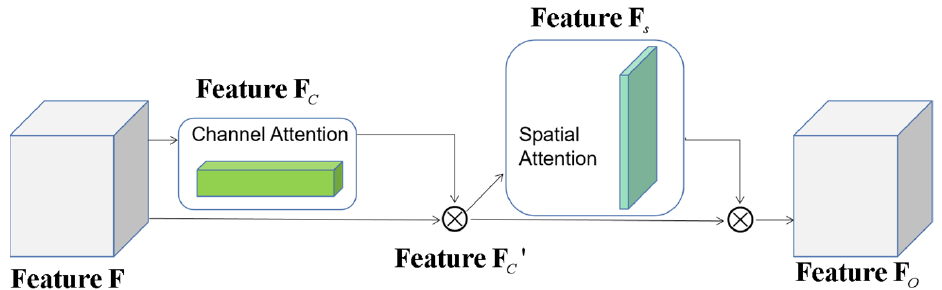
Figure 3. CBAM sketch map.